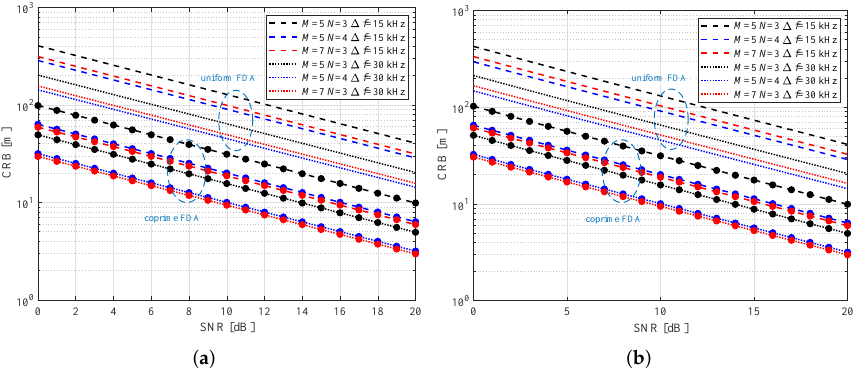
Figure 3. CRB of range in joint DOA-range estimation. ( a ) Deterministic signal case. ( b ) Stochastic signal case.